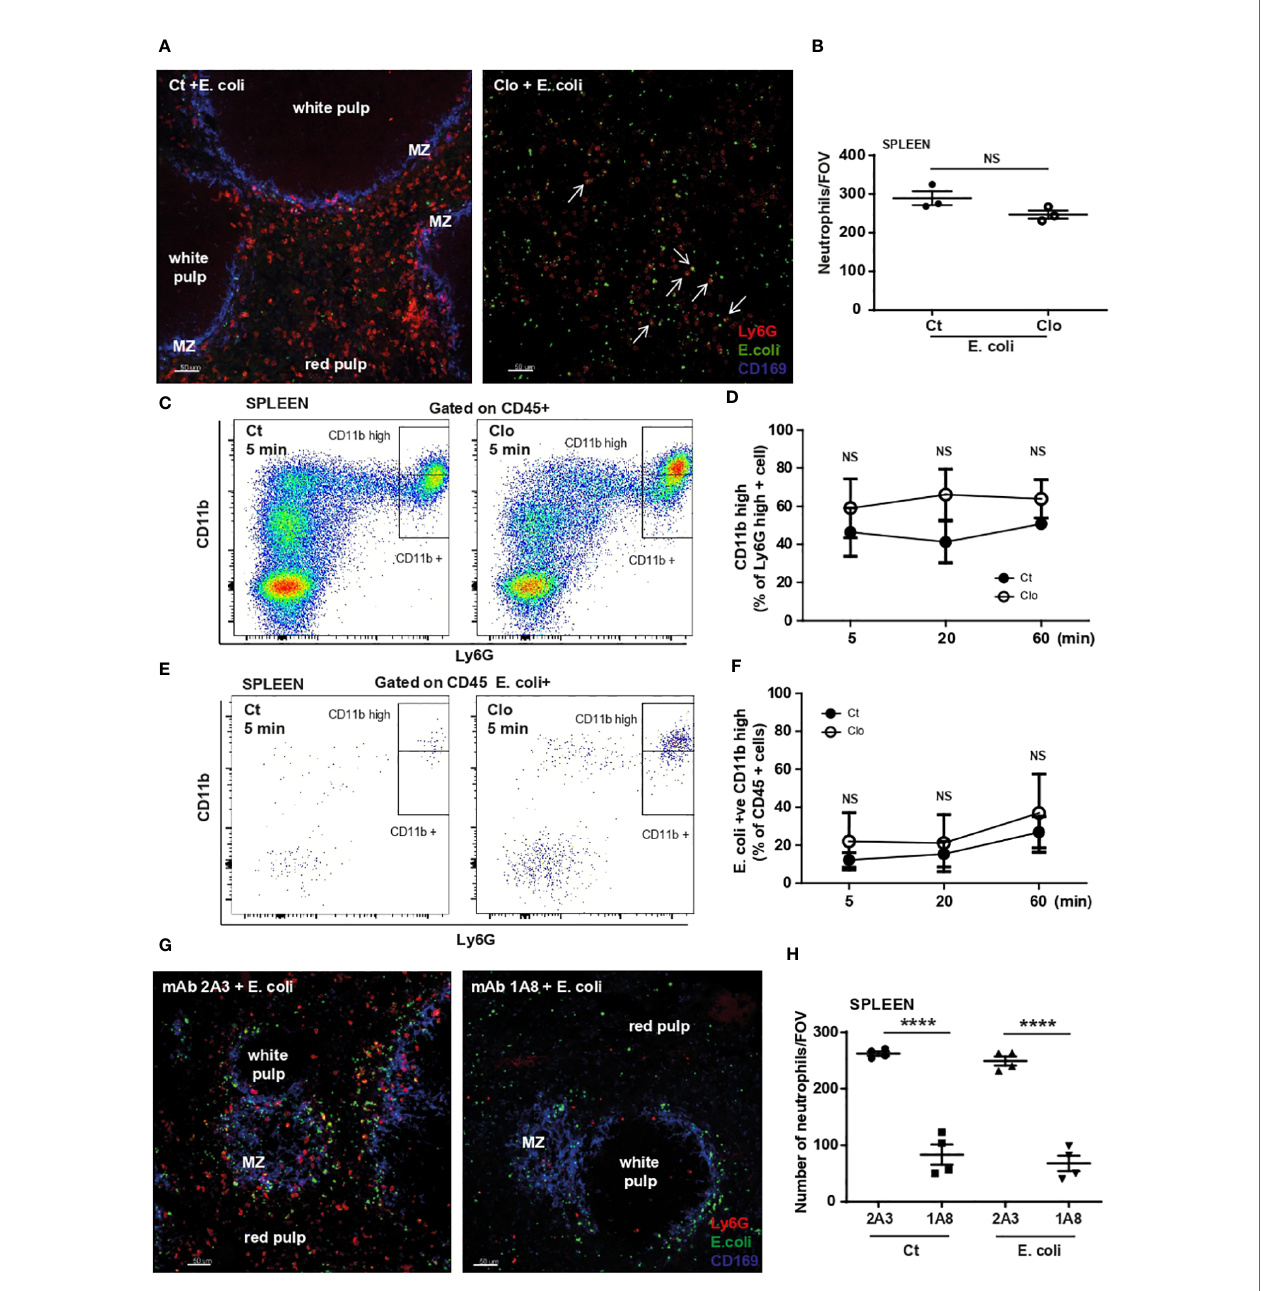
FIGURE 5 | MZ macrophages and splenic neutrophil functions during E. Coli challenge. (A) PCSS image of liposome-control (Ct) and liposome-clodronate (Clo) pre- treated mice challenged for 60 min with systemic E. coli . Scale bar 50 m m. Arrows point to some neutrophils that co-localize with E. coli . (B) Total number of neutrophils/FOV counted in PCSS of liposome-control and liposome-clodronate pre-treated mice challenged for 60 min with systemic E. coli , unpaired t-test (N=3 mice/treatment), (10 FOV/mouse). (C) Flow cytometry analysis of splenic neutrophils 5 min after i.v. injection of E. coli , representative of two independent experiments. (D) % of Ly6G high CD11b high neutrophils of liposome-control (Ct) and liposome-clodronate (Clo) pre-treated mice challenged for 5, 20, and 60 min with systemic E. coli , (N=4 mice/timepoint). (E) Flow cytometry analysis of E. coli -positive splenic cells 5 min after i.v. injection of E. coli , representative of two independent experiments. (F) E. coli -positive Ly6G high CD11b high neutrophils as % of CD45+ cells were calculated 5, 20 and 60 min post i.v. injection of heat-inactivated E. coli , (N=4 mice/timepoint). (G) PCSS image of 2A3 mAb and 1A8 mAb pre-treated mice challenged for 60 min with systemic E. coli . Scale bar 50 m m. (H) Total number of neutrophils/FOV counted in PCSS of 100 µg of 2A3 mAb and 100 µg of 1A8 mAb pre-treated mice challenged for 60 min with systemic PBS or E. coli . (N=4 mice/ group), (10 FOV/mouse). P < 0.0001 ****, NS, non signi fi